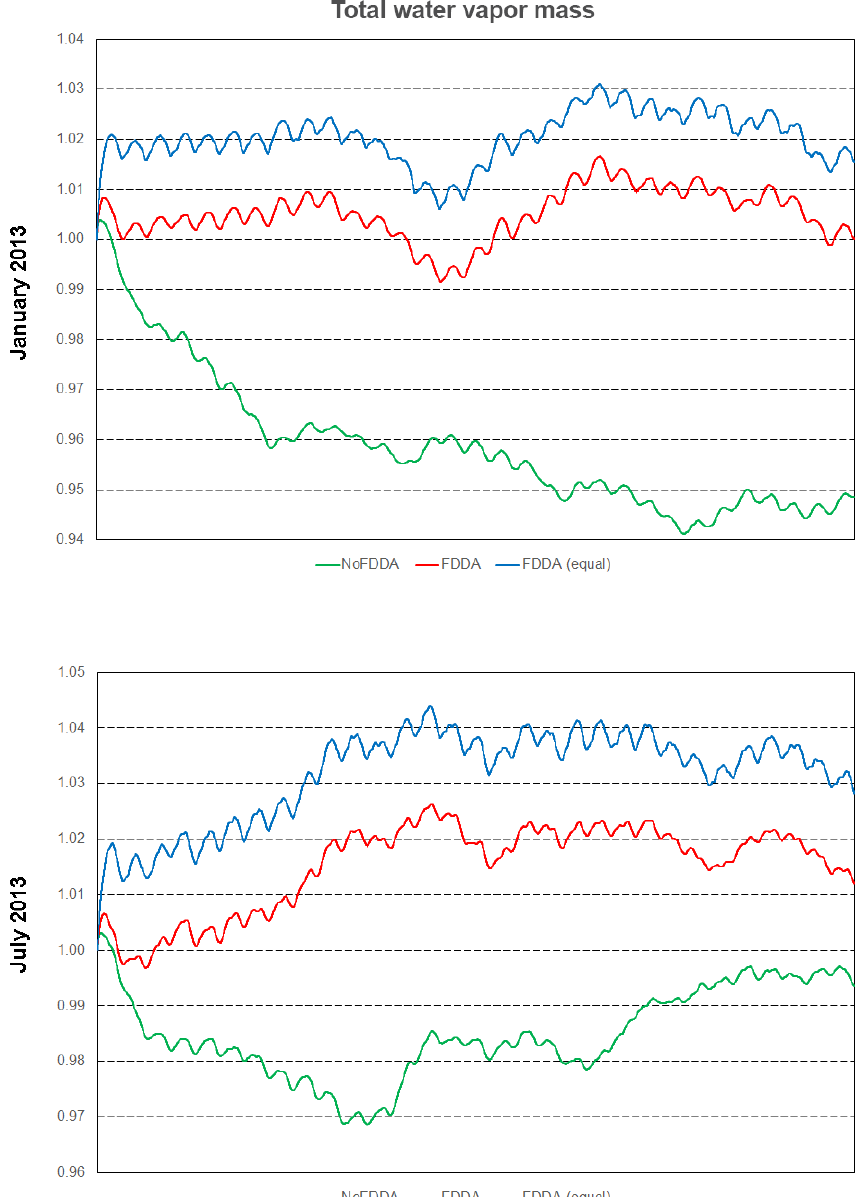
Figure 19. Time series plots of total water vapor mass scaled to their initial values for the two test periods. Results are from MPAS-A without FDDA (green line), MPAS-A using weaker q v nudging (red line), and MPAS-A using equal nudging for all variables (blue